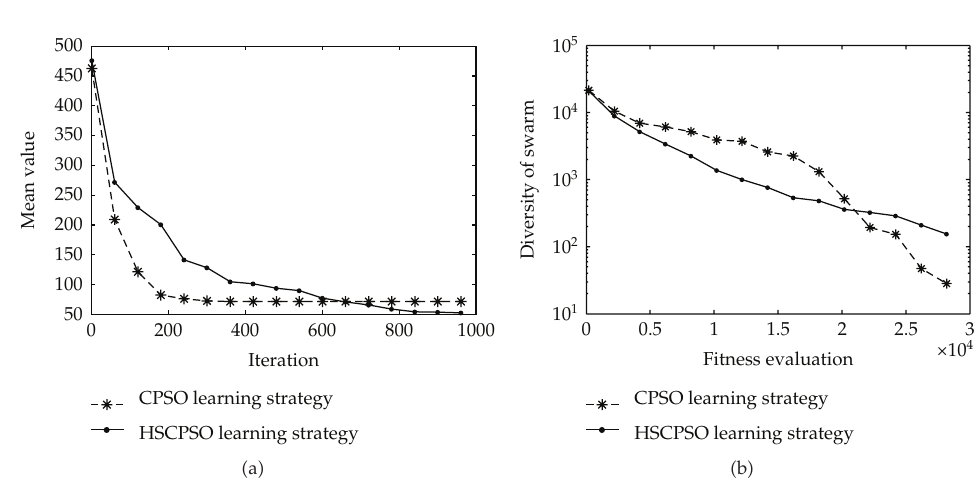
Figure 3: Comparison of the di ff erent learning